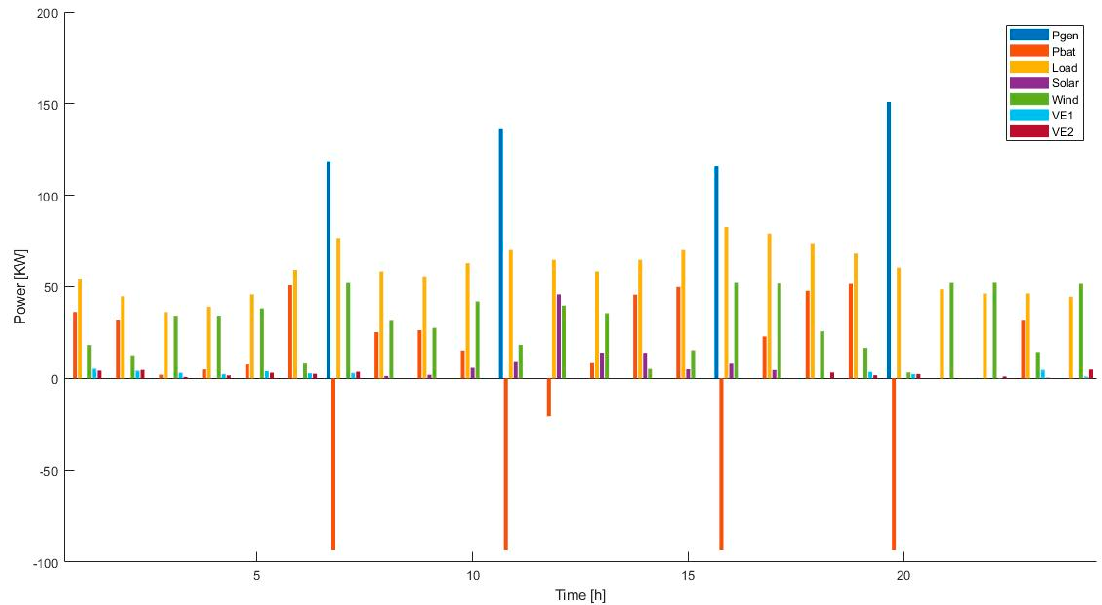
Figure 13. Availability and dispatch of the MG when the battery bank is new.